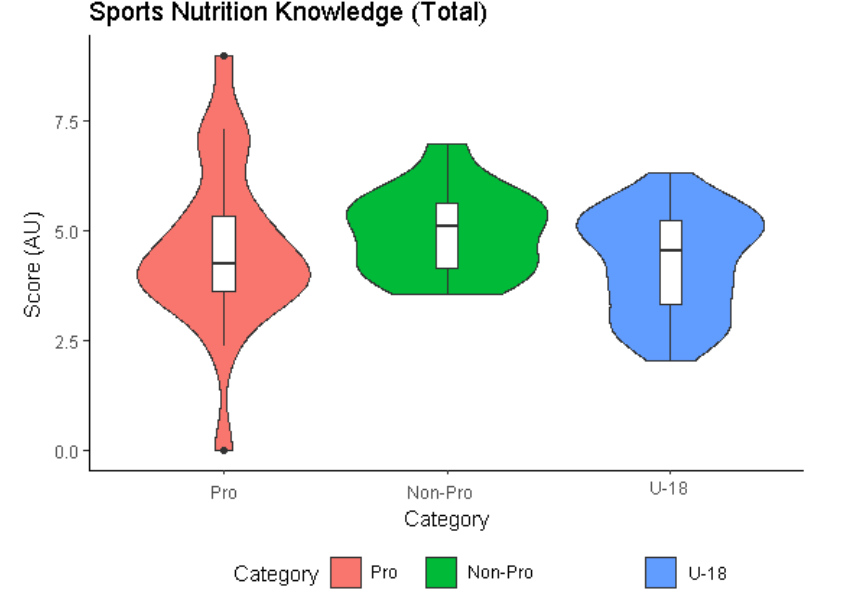
Figure 1. Sports nutrition knowledge (thematic blocks). Legend: * statistical significance differ- ence.